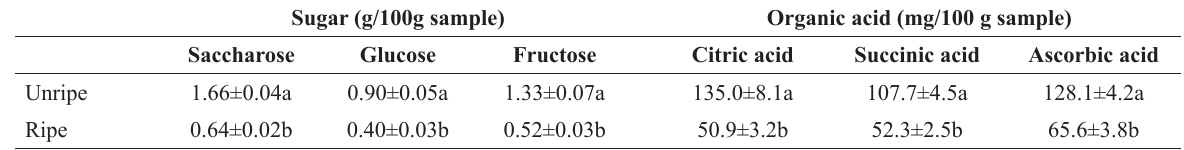
Organic acid and sugar content in Ackee arilli ( Blighia sapid a)